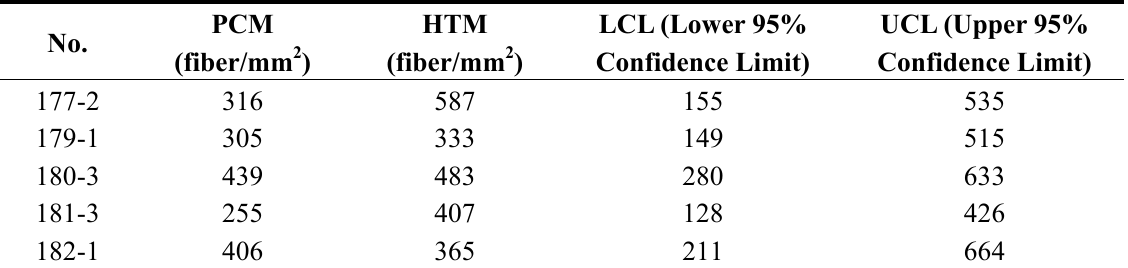
Table 1. Comparison of fiber density measured by PCM and HTM for PAT standard asbestos samples.